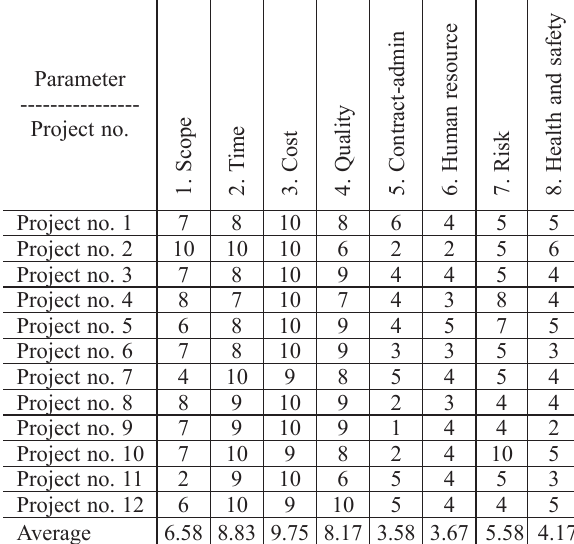
Table 2. Summary of average scores from the paired comparison exercise